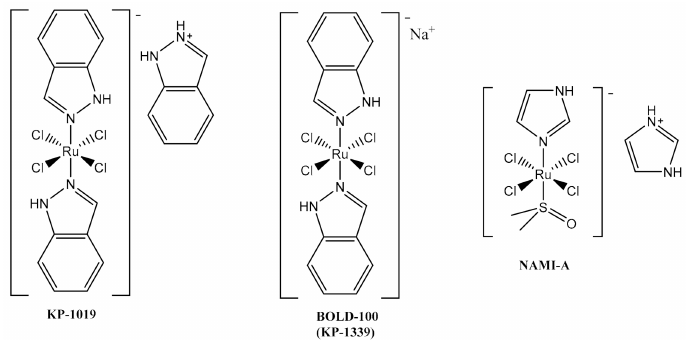
Figure 1. The structures of Ru(III) complexes in clinical trials.